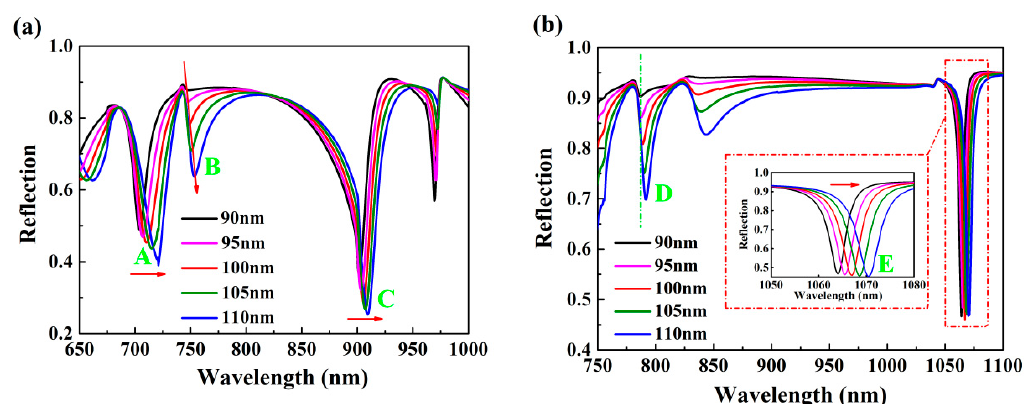
Figure 3. The effect of the thickness of gold layer h on reflection spectra under incident angle ( a ) 65° and ( b ) 30°.